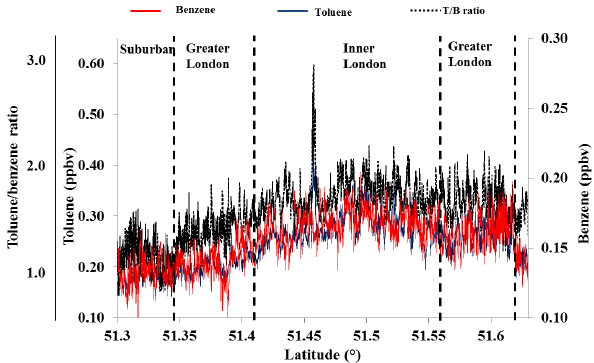
Figure 3. City cross section of 1km averaged benzene/toluene mixing ratios and T/B instantaneous ratios (ppbvppbv − 1 ) at 360 ± 10ma.g.l. across Greater London during RF 5.